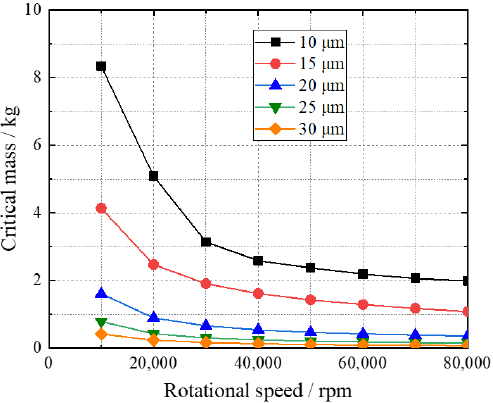
( b ) Figure 15. ( a ) Bearing load capacity and ( b ) attitude angle of hydrogen gas bearings with eccentricity ratio. The friction torque of the hydrogen gas bearing with eccentricity ratio is shown in Figure 16. The friction torque of hydrogen gas bearings increases with increasing eccen- tricity ratio. In addition, the difference in friction torque under different eccentricity ratios increases with rotational speed.